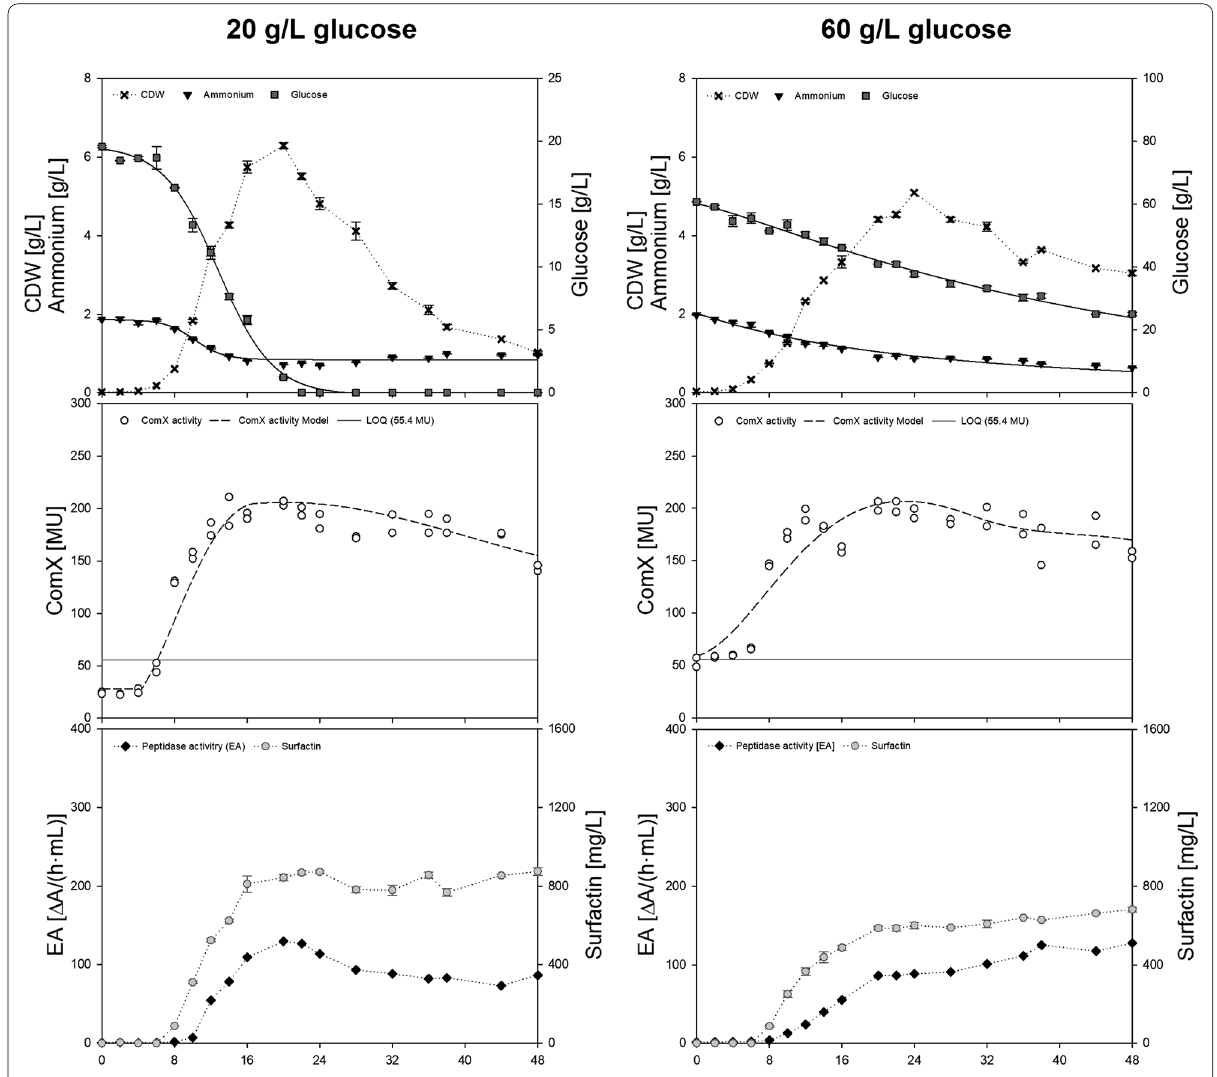
Fig. 4 Graphical illustration of exemplary bioreactor batch cultivations of B. subtilis DSM 10 T employing 20 and 60 g/L glucose. Each plot represents one of two biological replicates and the ComX activity (white circle) is additionally shown as technical replicate. The dashed black line represents the modeled ComX